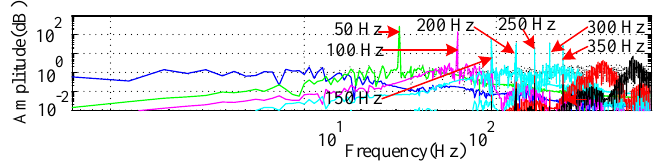
Figure 24. Waveforms of input signal with noise: ( a ) magnitude, ( b ) spectrum. Figure 25. Spectrums of VMD-HT algorithm decomposition under different modes. Figure 25. Spectrums of VMD-HT algorithm decomposition under different modes. Table 7. IO of VMD-HT algorithm decomposition under different K. Table 7. IO of VMD-HT algorithm decomposition under different K.